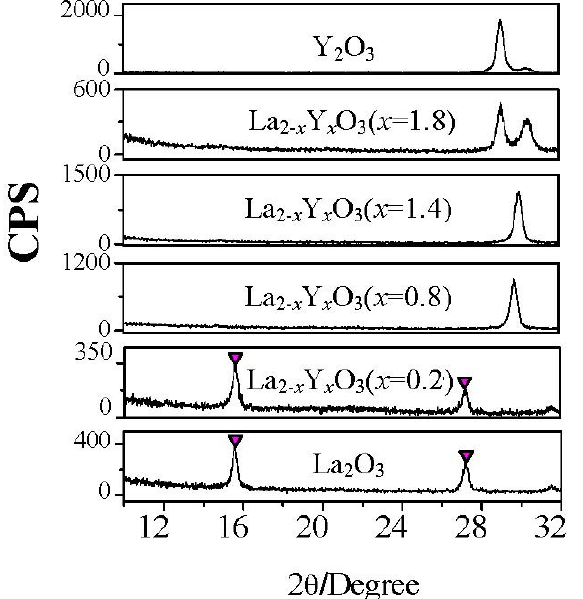
Figure 6. XRD patterns of La to air for 24 hours. Temperature and relative humidity of the air is 25 °C and 50% respectively. The films were annealed at 600 °C. ( :